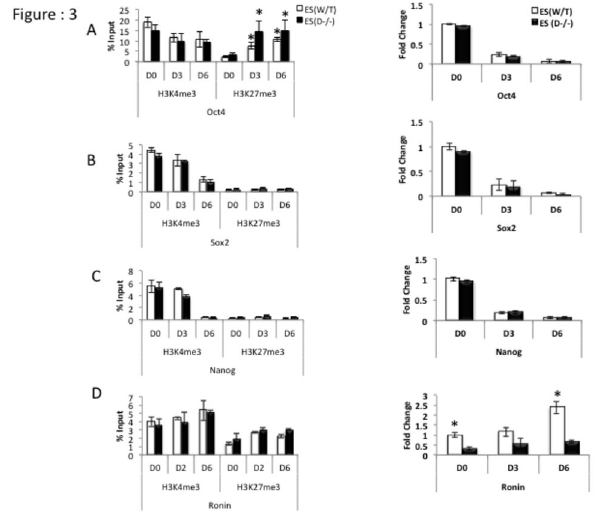
Figure 3. Enrichment levels of transcriptionally favorable versus transcriptionally unfavorable histone modifications in pluripotency factor gene promoter regions and their mRNA expression in mES cells. A, B, C and D left ChIP- qPCR and right panels qRT-PCR results of relative mRNA levels in Oct4 , Sox 2 , Nanog and Ronin in WT and Dicer -/- ES cells upon RA induced differentiation through days 0 (D0) to 6 (D6). A and B right panels transcripts of Oct4 and Sox2 go down both in mES and Dicer -/- ES cells upon RA treatment (A and B left panels). Transcriptionally favorable (H3K4me3) and unfavorable (H3K27me3) presence at Oct4 and Sox2 promoters in WT ES and Dicer -/- ES (C right panel). Expression levels of Nanog go down upon RA induction while transcriptionally favorable H3K4me3 marks gradually go down in both cell lines (C left panel) (D left panel). H3K4me3 and H3K27me3 occupation at the Ronin promoter (D right panel). Transcripts of Ronin go up at a higher rate in Dicer -/- ES cells compared to WT ES cells. Figure 3A Left panel * indicates that the difference for a given cell line at a given time point was significant when compared to day zero of the same cell line at 0.05 confidence levels when a students t-test was performed. Figure 3D right panel * indicates that the difference at a given time point between the two cell lines were significant at 0.05 confidence levels when a students t-test was performed. doi: induction transcripts of pluripotency factors Oct4 Sox2 and Nanog gradually went down in both WT and Dicer -/- ES cells at comparable rates (Figure 3A–C right panels). However transcripts of Ronin (Figure 3D right panel) was found to be significantly lower in Dicer -/- ES cells. ChIP-qPCR on promoter regions of the pluripotency genes Oct4, Sox2 , Nanog and Ronin showed no consistent change in H3K4me3 and H3K27me3 marks in Dicer -/- ES cells compared to WT ES cells (Figure 3A to 3D left panels). However, an increase of H3K27me3 marks in response to RA treatment was noticeable in both cell lines at the Oct4 promoter (Figure 3A Left panel).